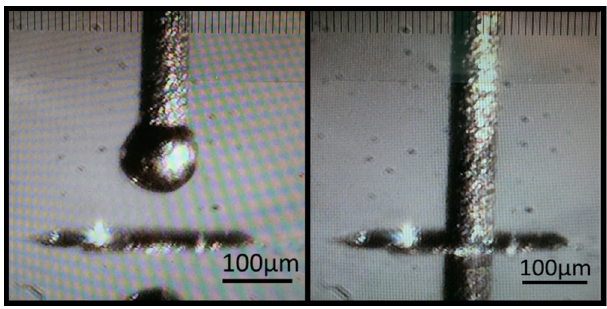
Figure 13. Depth of a micro ‐ hole being measured by the probing head.